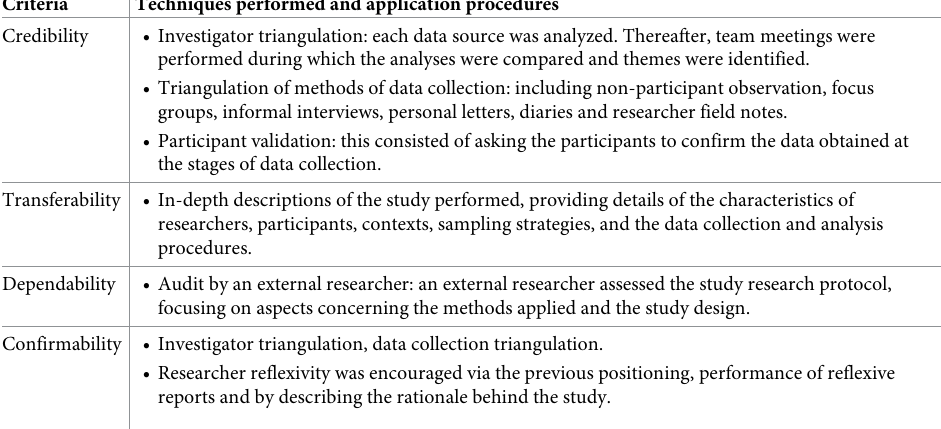
Table 3. Trustworthiness criteria